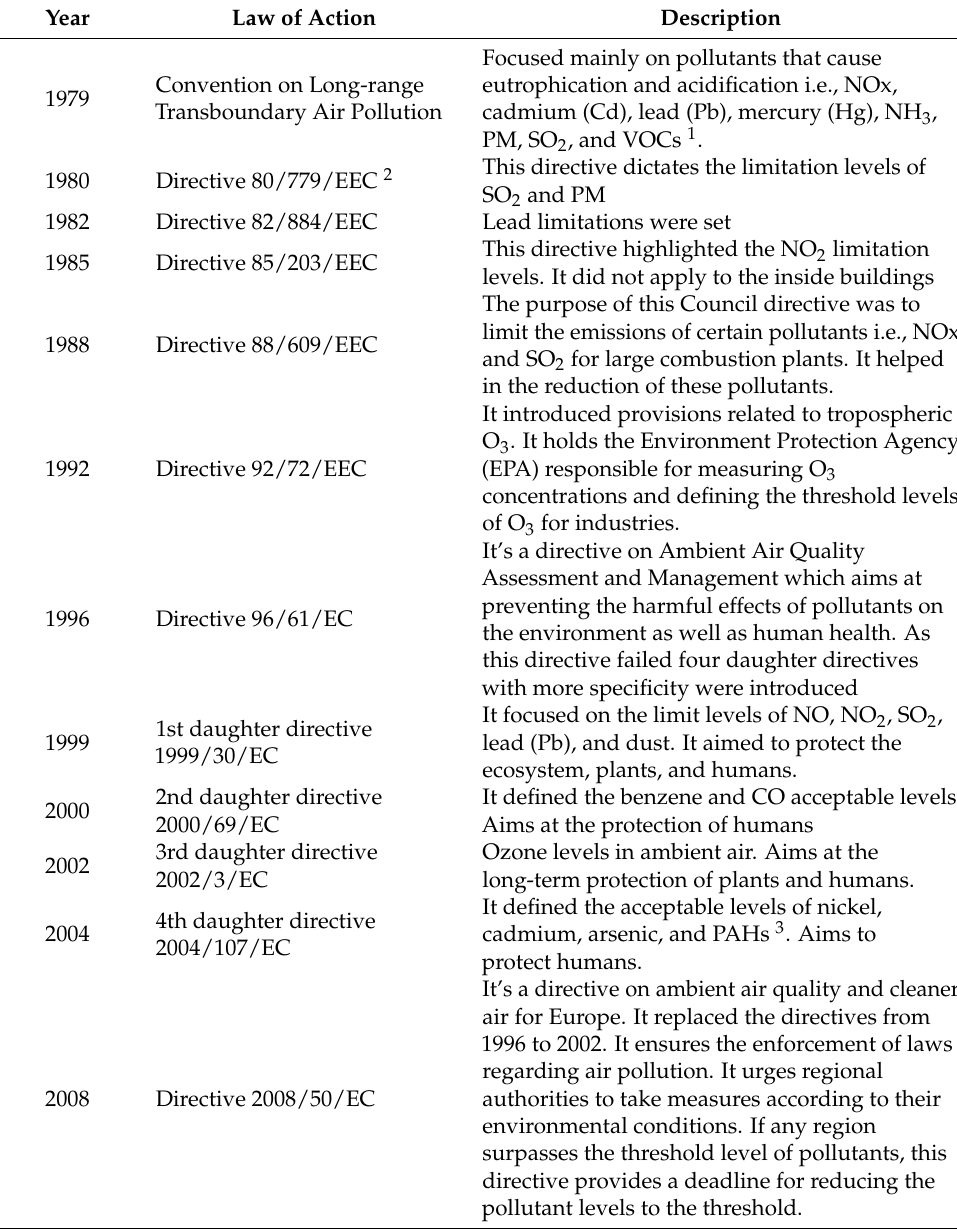
Table 4. Evolution of European Union legislation on air pollution